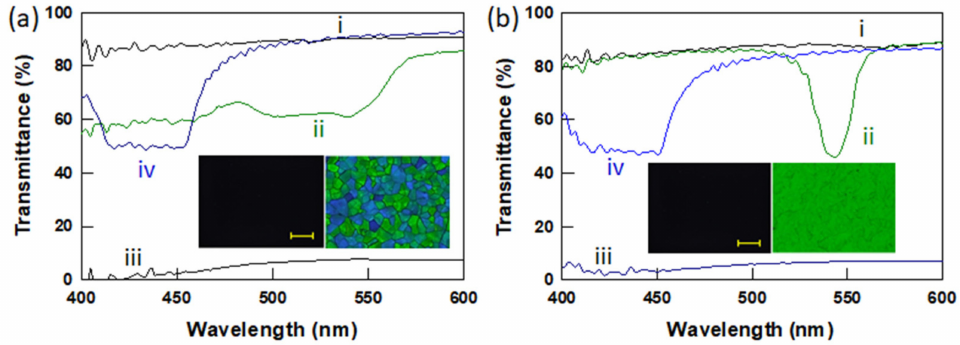
Figure 2. Transmission spectra and POM images of BPLC-3 prepared in ( a ) an unaligned cell at ( i ) 41 ◦ C (isotropic), ( ii ) 26 ◦ C (BP-I), ( iii ) 22 ◦ C (focal-conic phase), and ( iv ) CLC phase after rubbing; and ( b ) an aligned cell at ( i ) 41 ◦ C (isotropic), ( ii ) 26 ◦ C (BP-I), ( iii ) 22 ◦ C (focal-conic phase), and ( iv ) CLC phase after rubbing. Transmission spectra and POM images are monitored during cooling at a rate of 0.1 ◦ C min − 1 . The LC mixture contains 6 wt% SL04151, 3 wt% PETA, 4 wt% R1011, 21 wt% R811, and 66 wt% E7. Scale bar in the POM images is 50 µ m. Cells of 11.2 µ m thickness were used.